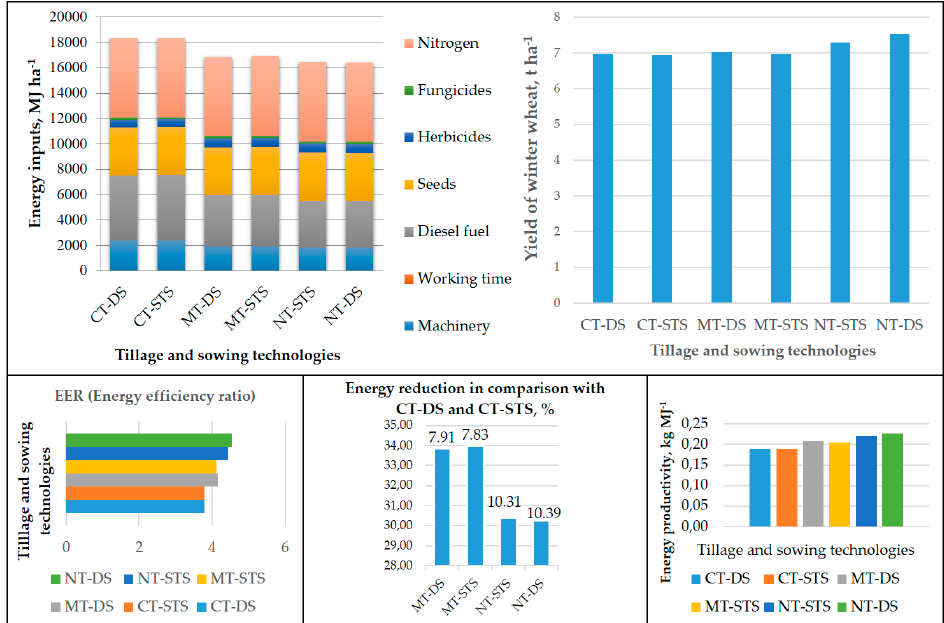
Figure 5. Total energy input in winter rape production for different tillage and sowing technologies and EER, energy productivity, and energy reduction.